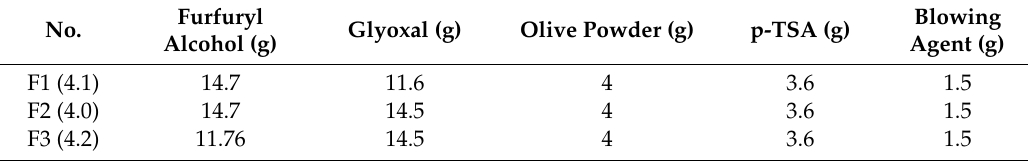
Table 1. Formulations for preparing the furanic-glyoxal